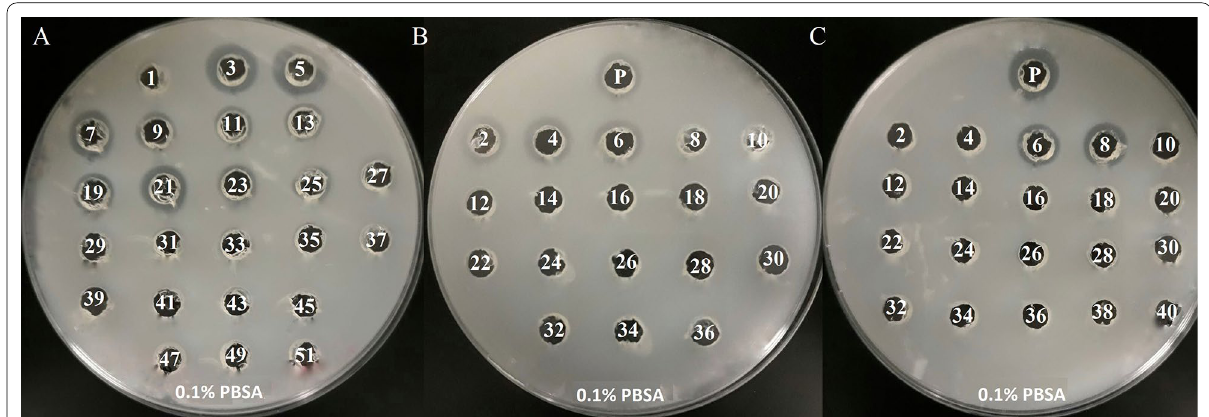
Fig. 2 Biodegradation activity towards 0.1% PBSA in a plate assay exhibited by fractions collected throughout chromatographic steps: A pH 8.0, Bio-Scale Mini UNOsphere Q 5 mL; B pH 9.0, Bio-Scale Mini UNOsphere Q 5 mL; C pH 9.0, Bio-Scale Mini UNOsphere Q 1 mL. The numbers represent the consecutively collected factions; the letter P represents permeate